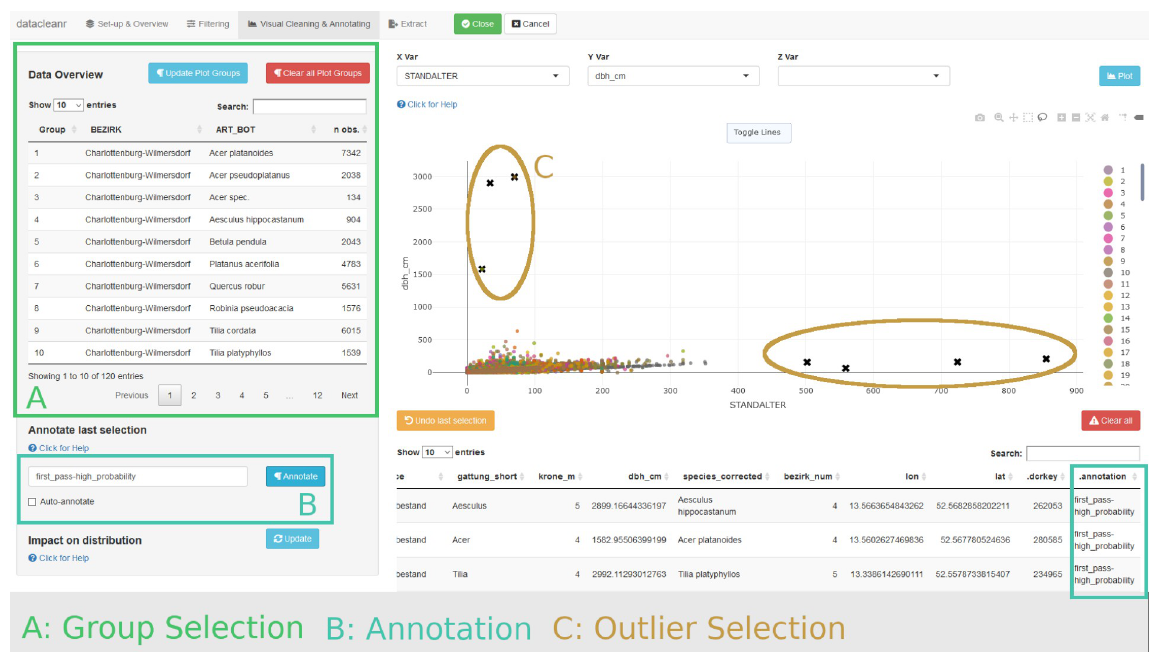
Fig 7. Overview of visual cleaning tab for Berlin tree data. The plot shows tree age (x) and diameter (y), resolving nesting by district and species. All 120 groups are displayed (see A, and figure legend). Potential outliers are obvious and easily highlighted and annotated for later reference (B, C). The dense point cloud comprises nearly 320000 observations and requires further inspection.